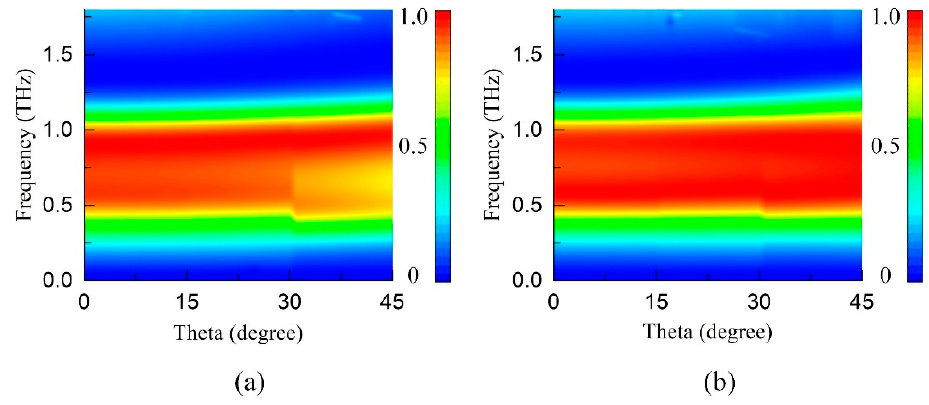
Figure 4. Absorption of the TMA as a function of frequency and incident angle. ( a ) TE, ( b )